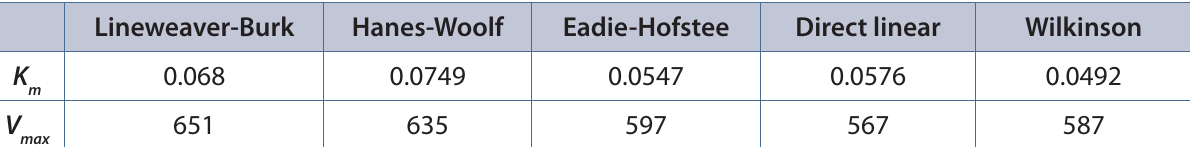
Table 1. K and V values from different plots m max Lineweaver-Burk